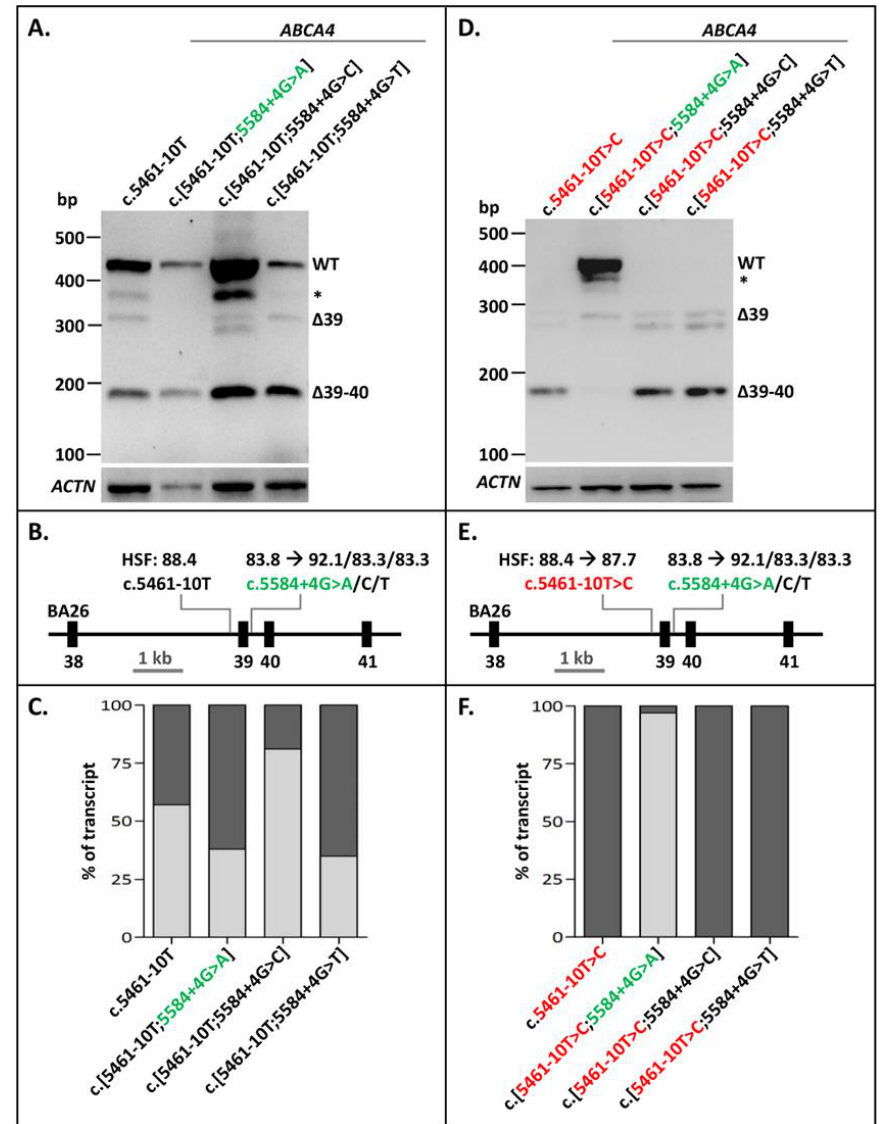
Figure 1. Rescue of Exon 39 / 40 skipping due to ABCA4 variant c.5461-10T > C by 5 (cid:48) -splice-site strengthening. ( A ) The e ff ect of altered nucleotides at Position c.5584 + 4 in the WT BA26 construct. None of the variants had a significant e ff ect on Exon 39 / 40 splicing. Natural skipping of Exons 39 / 40 was observed for all. ( B ) Schematic overview of the BA26 construct used in A annotated with the Human Splicing Finder (HSF) scores with a range of [0–100], of which a higher score indicates a stronger splice prediction. ( C ) Semi-quantification of the ratio of correctly (light gray rectangles) and aberrantly spliced (dark gray rectangles) RT-PCR products due to altered nucleotides at Position c.5584 + 4 in the WT BA26 constructs. When multiple aberrant products were observed, the percentages were summed up. ( D ) The e ff ects of altered nucleotides at c.5584 + 4 in the BA26 construct containing the c.5461-10T > C variant were that c.5584 + 4G > A, but not + 4G > C or + 4G > T, rescued the exon skipping due to c.5461-10T > C. ( E ) Schematic overview of the BA26 construct used in B. ( F ) Semi-quantification of the ratio of correctly (light gray rectangles) and aberrantly spliced (dark gray rectangles) RT-PCR products in BA26 construct containing c.5461-10T > C alone and together with rescue variants. * Band was identified as heteroduplex by Sanger sequencing. Red lettering indicates pathogenic variant. Green lettering indicates variant that rescued exon